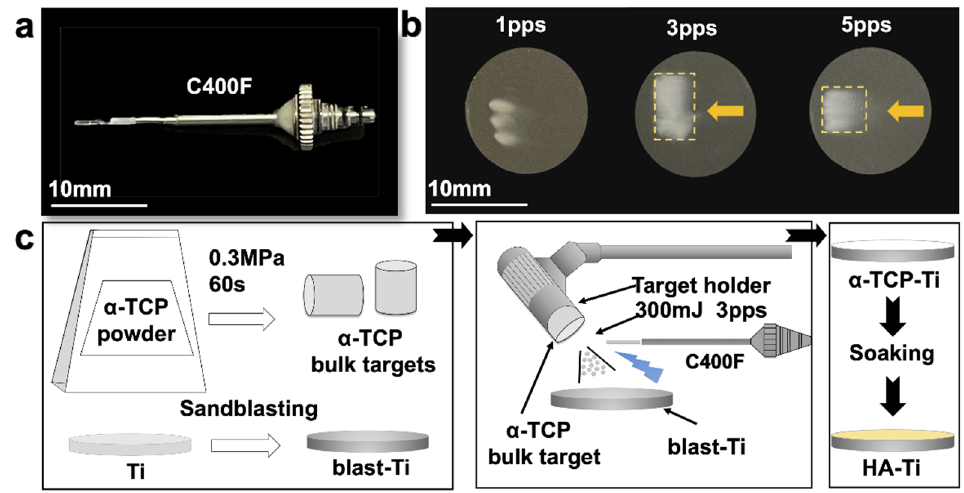
Figure 1. ( a ) The straightened C400F contact tip. ( b ) Gross appearances of the α -TCP coatings. ( c ) Fabrication procedure of the HA coating. ( c ) Fabrication procedure of the HA